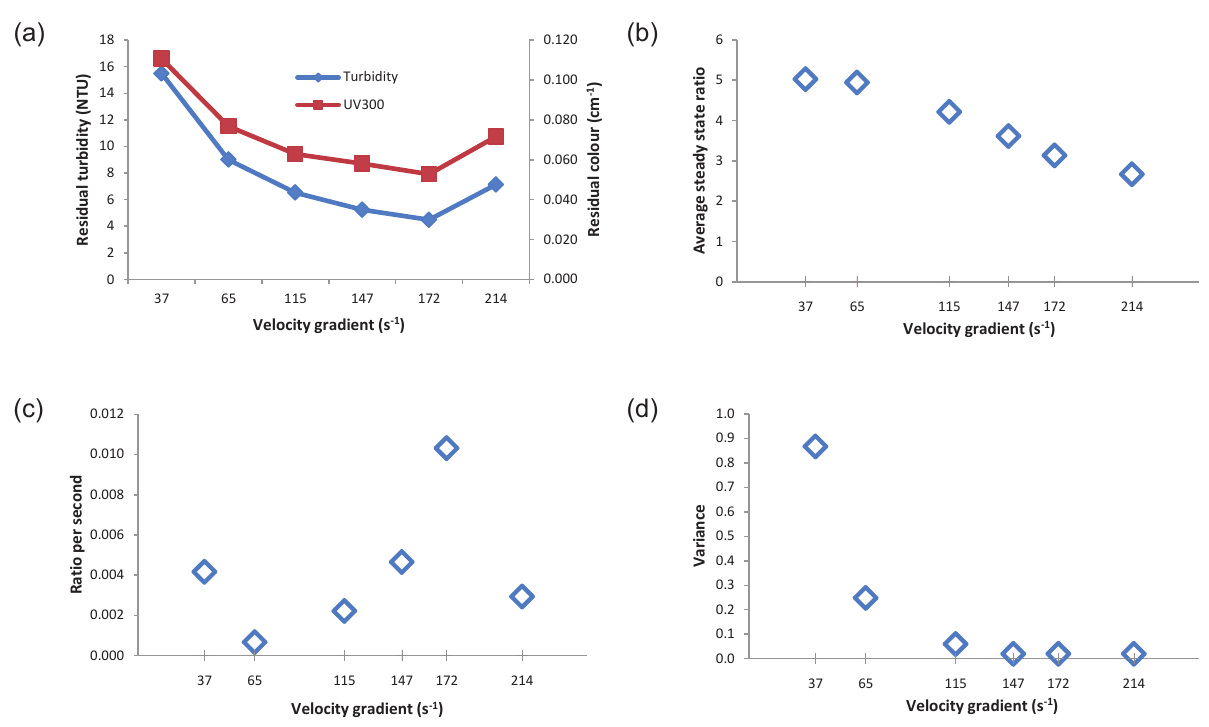
Figure 6. Optimization of velocity gradient – (a) residual turbidity and colour; (b) Average steady-state ratio; (c) aggregation rate; (d) steady-state